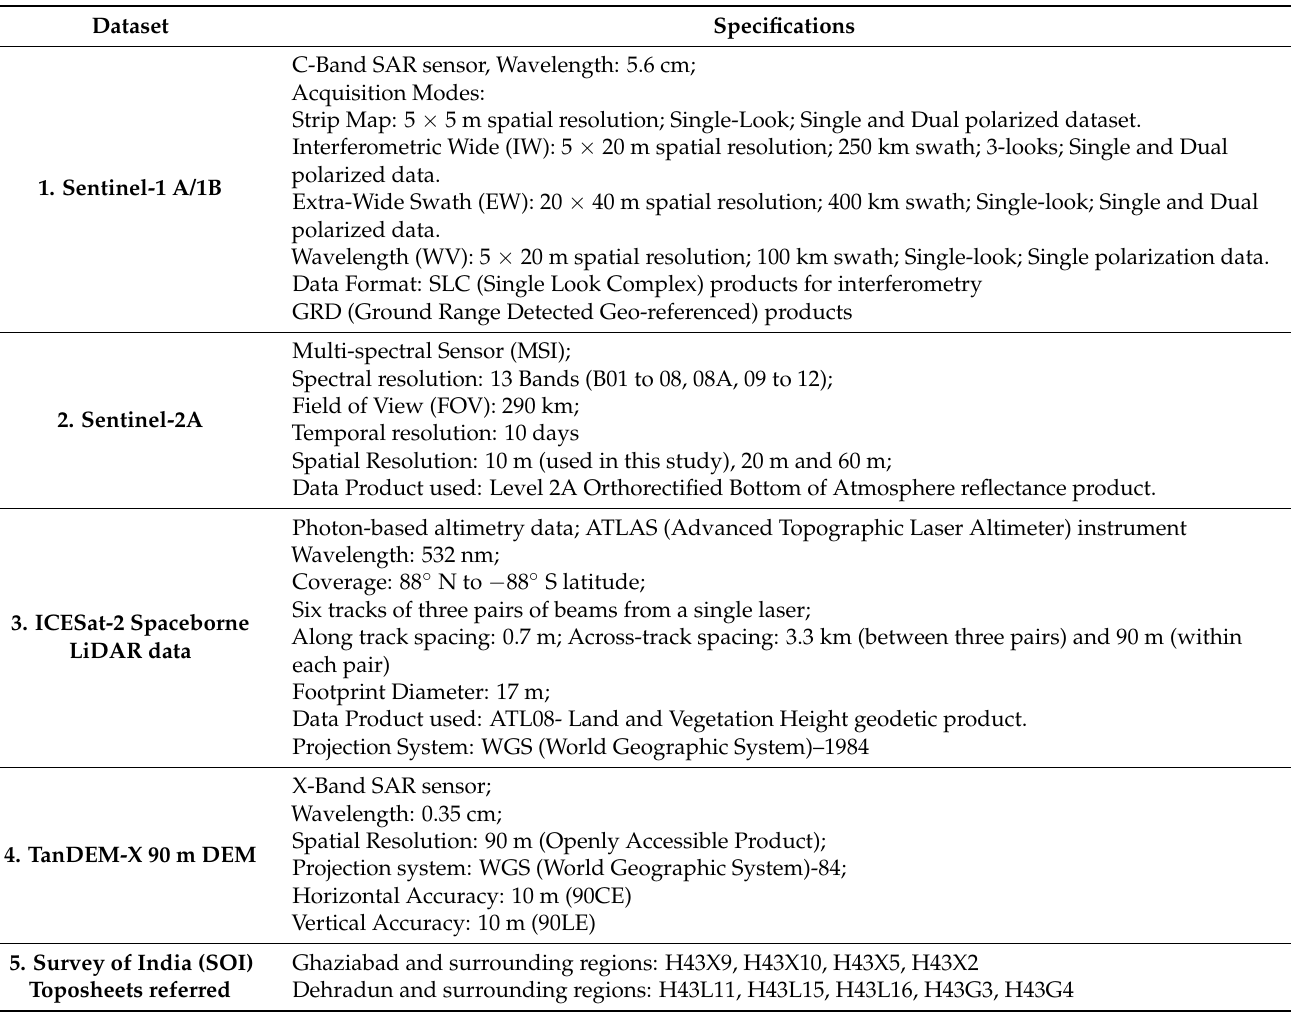
Table 1. Materials used and their